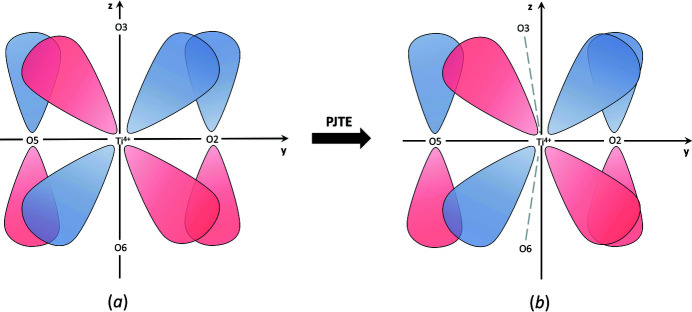
Visual representation of the pseudo Jahn–Teller effect for a TiO6 octahedron. O1 and O4 are directly above and below Ti4+ in (a); blue lobes are (+) and red (−). In the high-symmetry configuration (a), the overlap integral between the HOMO |t
1u
z〉 (from O2−) and LUMO |3dyz〉 (from Ti4+) is null. However, displacement of Ti4+ along the y axis (b) results in both an increase in positive overlap (+/+ and −/−) and a decrease in negative overlap (+/−), thus resulting in spontaneous distortion.